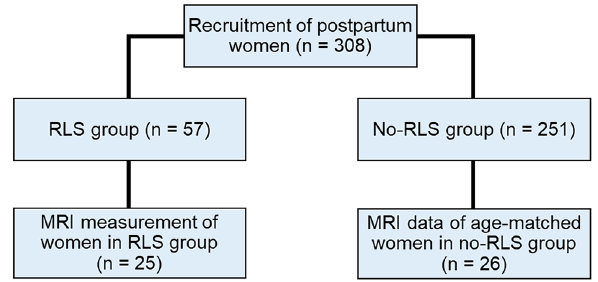
Figure 4. Flowchart of inclusion into the